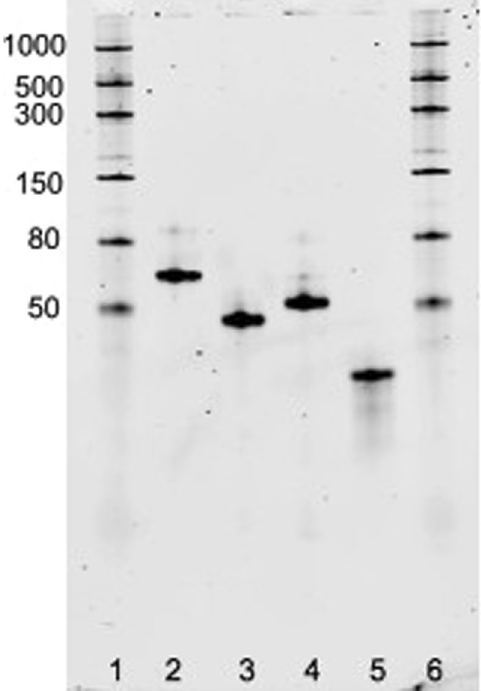
Figure 3. 10% TBE-Urea gel electrophoresis after SYBR ® Gold staining. Lanes: 1, 6: ssRNA ladder; 2: Broccoli aptamer; 3: Split1; 4: Split2; 5: complementary Split1/Split2 De Bruijn sequence. Molecular sizes in nucleotides are